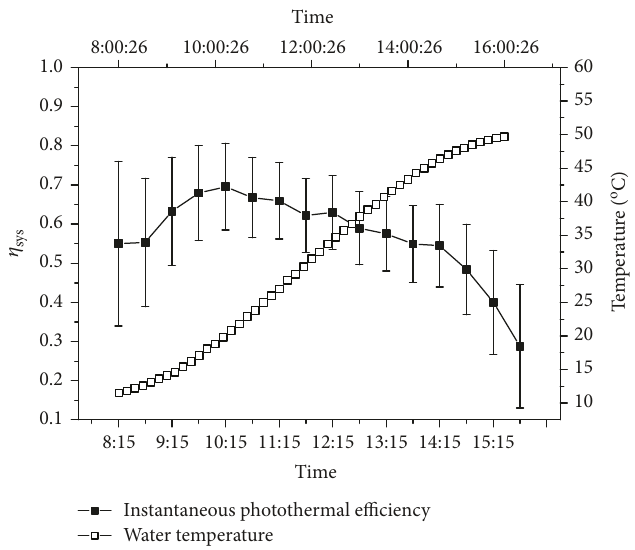
Figure 4: Variations in instantaneous photothermal e ffi ciency and water